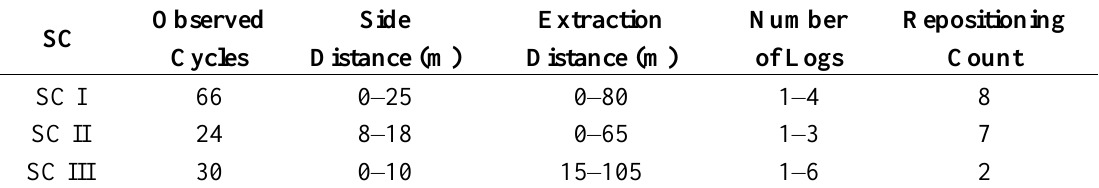
Table 3. Summary count of external data collected for each